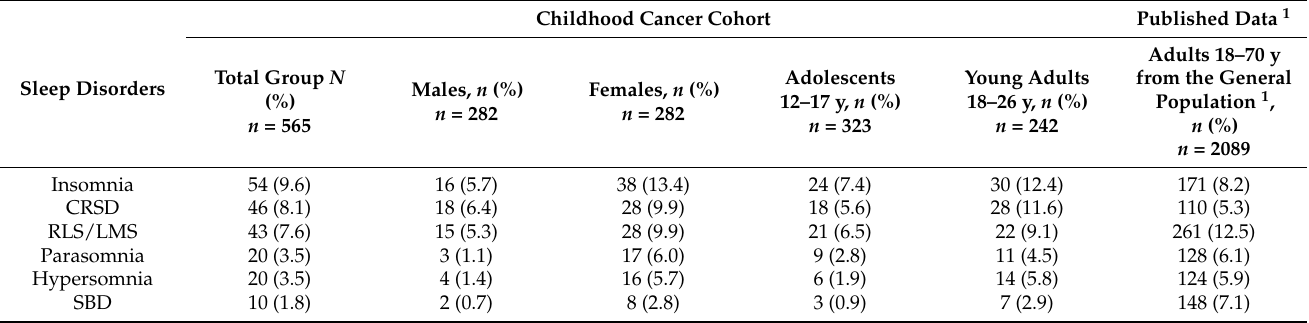
Table 2. Prevalence rates of subjective sleep disorders in the total group, per sex and per age group, with comparison to published